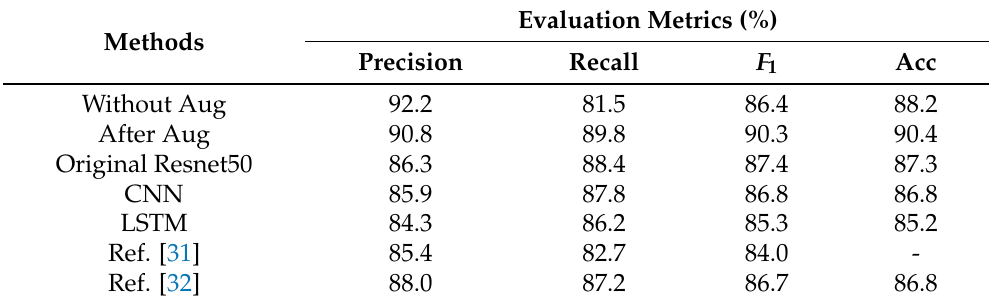
Table 3. Results after data augmentation and comparison with the performance of other models (“-” denotes that data is